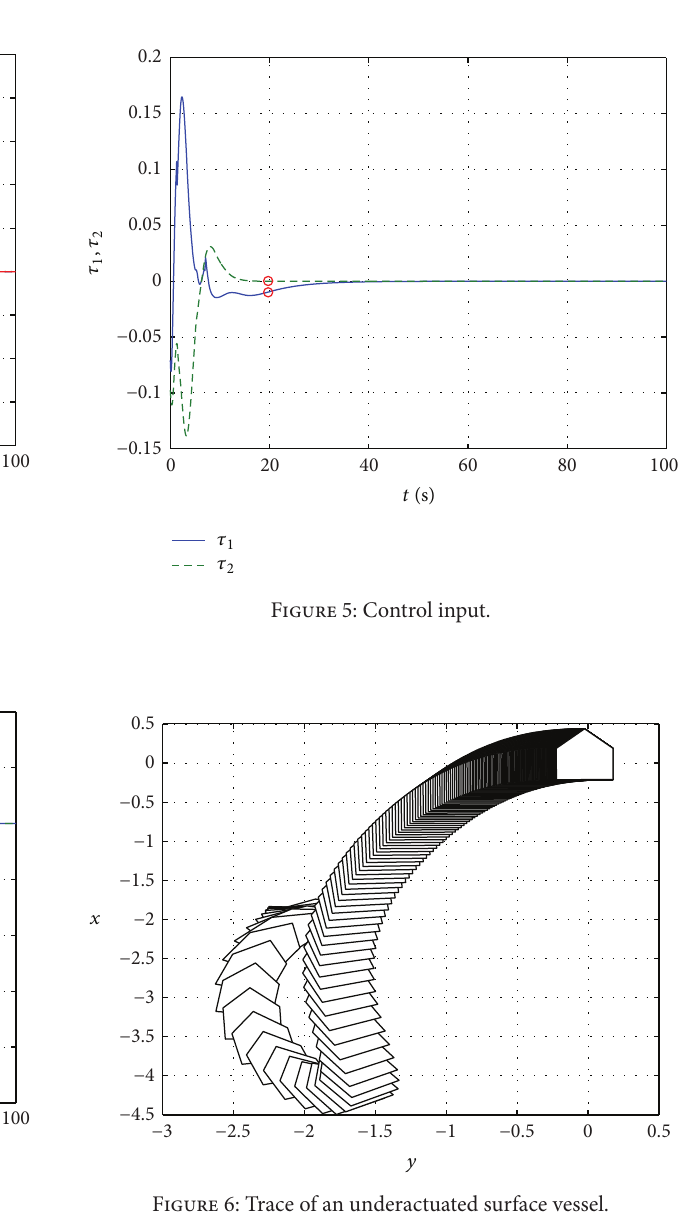
Figure 6: Trace of an underactuated surface